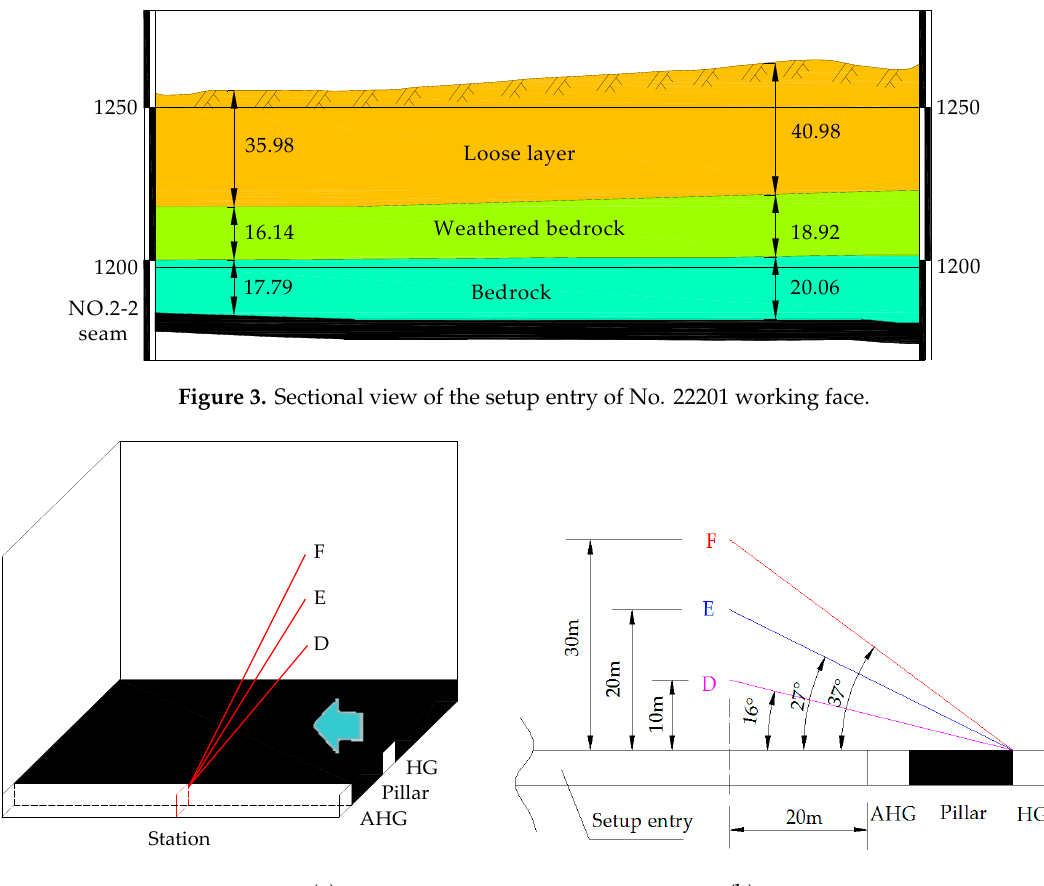
Figure 4. Drillholes design in AHG: (a) Spatial distribution diagram; (b) Sectional view.